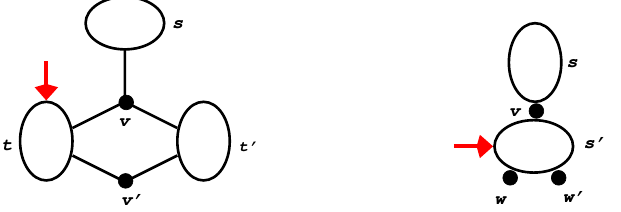
Figure 2. A contraction on vertices ( left ), and a contraction on hyperedges ( right